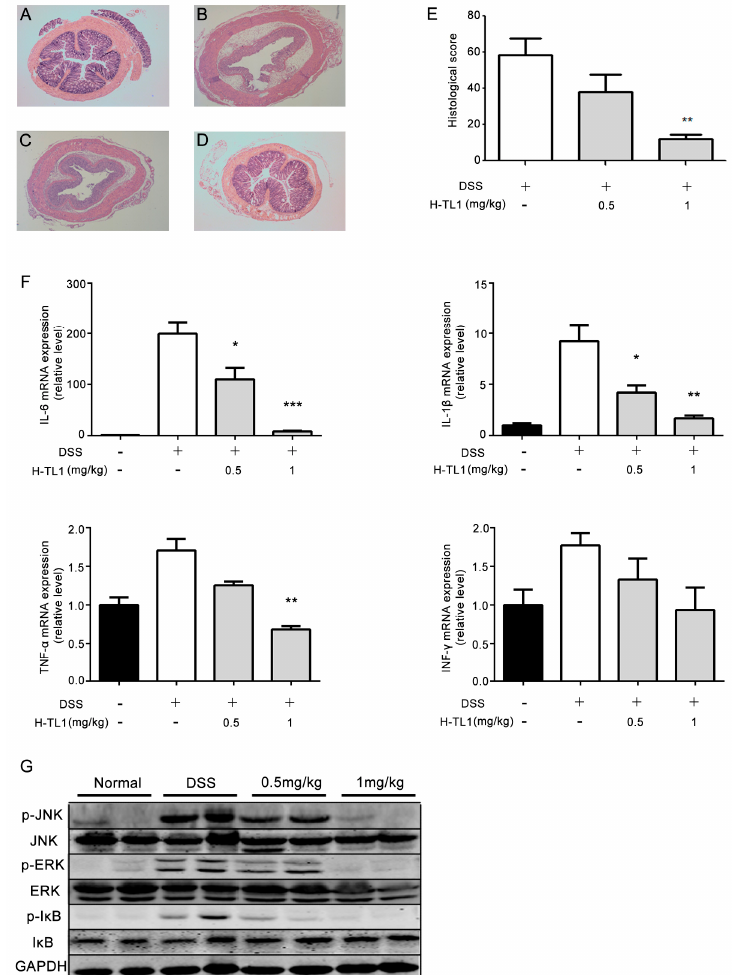
Figure 4. The effect of H-TL1 on inflammatory parameters: histological score, cytokines, and signaling pathways: ( A ) normal mucosa of BALB/c mouse; ( B ) severe inflammation, including complete destruction of epithelial architecture with loss of crypts and epithelial integrity, submucosal edema, and extensive inflammatory cellular infiltration in DSS + vehicle mice; ( C ) treatment with 0.5 mg/kg H-TL1 had little effect on DSS-induced colonic inflammation; ( D ) treatment with 1 mg/kg H-TL1 alleviated DSS-induced colonic inflammation; ( E ) histological score of DSS-induced colonic inflammation in mice treated with vehicle or H-TL1; ( F ) H-TL1 treatment reduced mRNA expression of inflammatory mediators; and ( G ) H-TL1 inhibited DSS-induced NF- κ B and MAPK activation through phosphorylation of ERK(Thr202/Tyr204), JNK (Thr183/Tyr185), and I κ B (Ser32/36). Values represent means ± SEM ( E : n = 8; F : n = 3), * p < 0.05, ** p < 0.01, and *** p < 0.001 vs. DSS only group. H&E (hematoxylin and eosin) staining, 40× magnification.